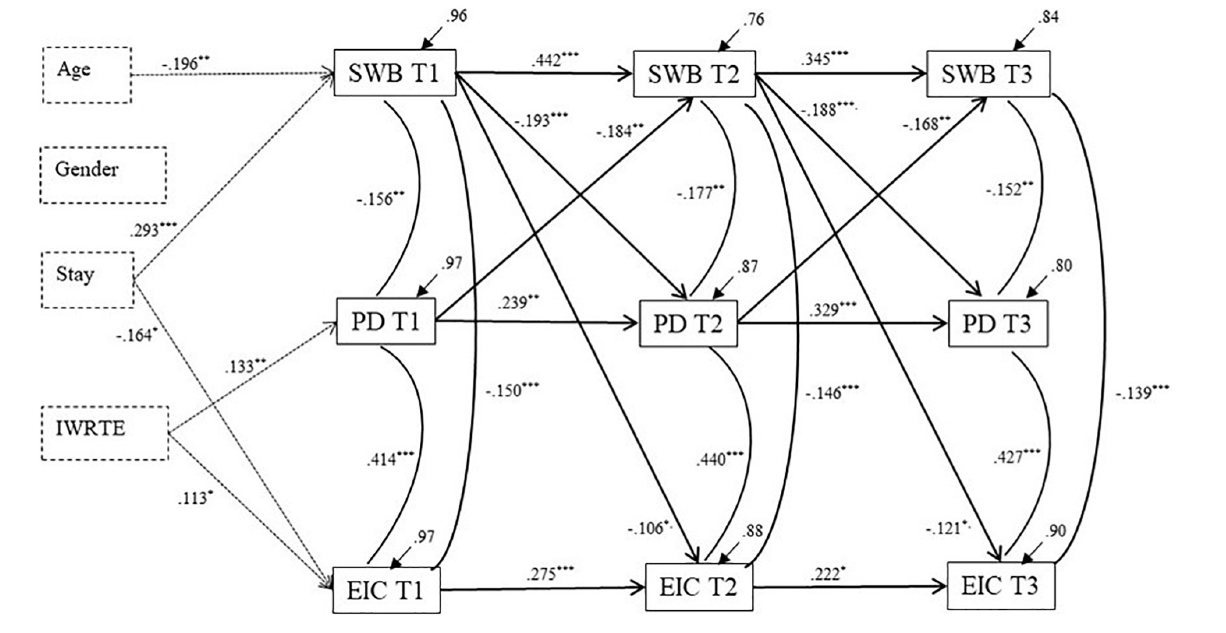
within person variation in the reported levels of these factors across the